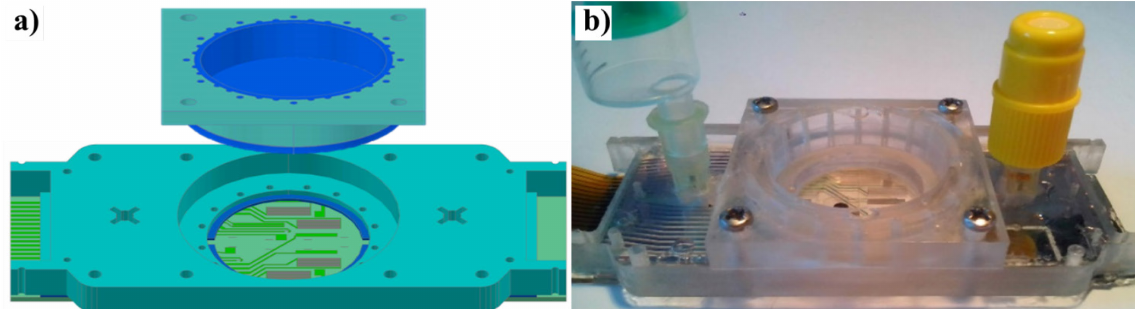
Figure 2. Computer-aided design of the microfluidic system ( a ) with the body (bottom) and lid (top) milled in polycarbonate (light turquoise). The blue polydimethylsiloxane (PDMS)-imprinted parts (gasket with fluidic channels in the body and PDMS membrane in the lid) confine the fluidic volume. The laser-structured chip (green) is glued to the lower PDMS surface. ( b ) The assembled cell culture system with a flexible printed circuit board connector (lower left), as well as a syringe and syringe-injection cap on the left and right inlets,